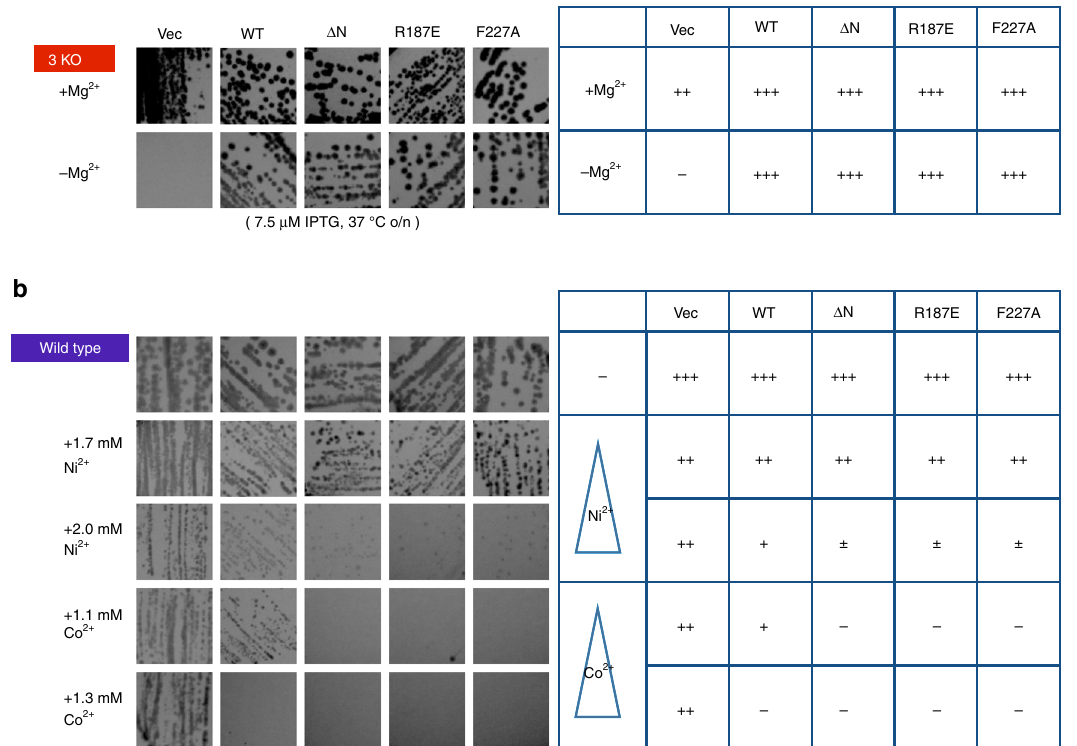
the search models, respectively. The models were subsequently improved through iterative cycles of manual building with COOT 44 and re fi nement with the program PHENIX 45 . The structure re fi nement statistics are summarized in Table 1. Molecular graphics were illustrated with CueMol (http://www.cuemol.org). Limited Proteolysis . The full-length WT and mutant MgtE proteins were prepared as described above. The 9 µ l reaction-premix contained 4 µ l of the